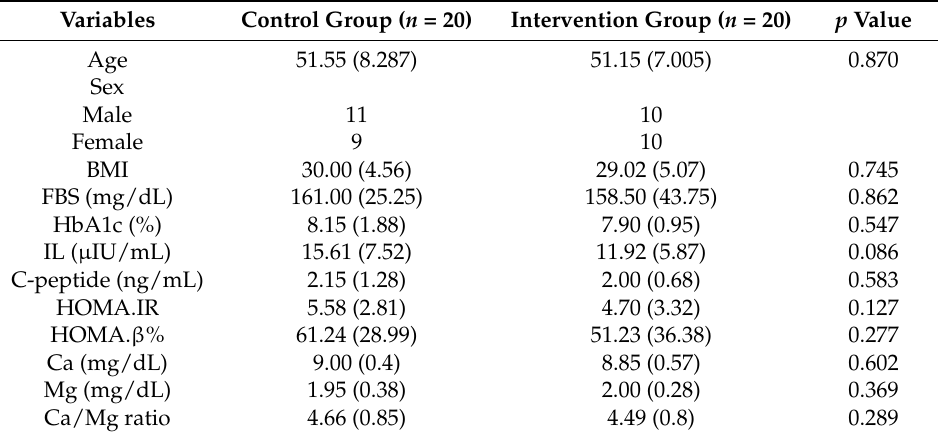
Table 1. Baseline characteristics of the respondents.